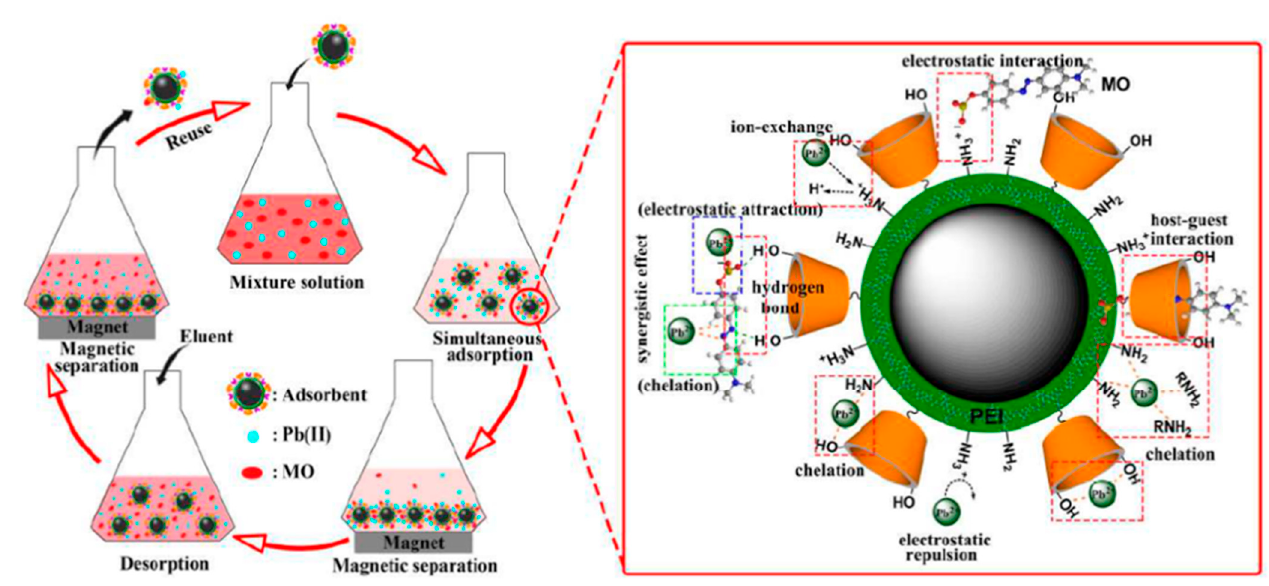
Figure 5. A versatile β -CD and PEI bi-functionalized magnetic nanoadsorbent with spatially separated sorption sites (denoted as Fe 3 O 4 -PEI/ β -CD) was successfully constructed for simultaneous removal of methyl orange (MO) and Pb(II) from complex wastewater through multiple mechanisms (such as electrostatic attraction, host–guest inclusion, chelating, etc.); reproduced with permission of Elsevier [114].